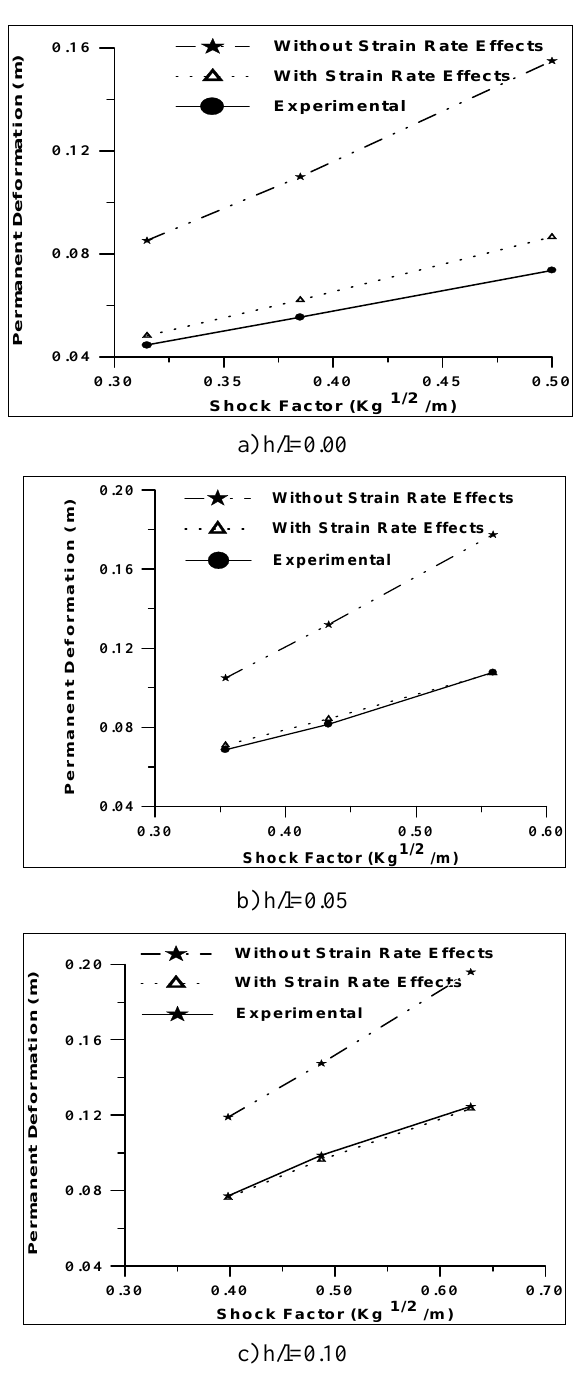
Fig. 13. Comparison of central (Point C in Fig. 3) permanent deformation for various shell panels. strain rate considerably affects the dynamic